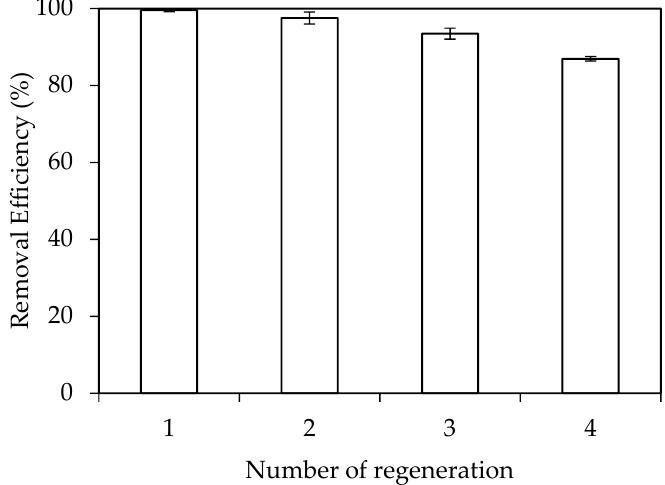
Figure 13. Removal efficiency of RhB using SMNA after four regenerations. Error bars show standard deviation of three replicates.